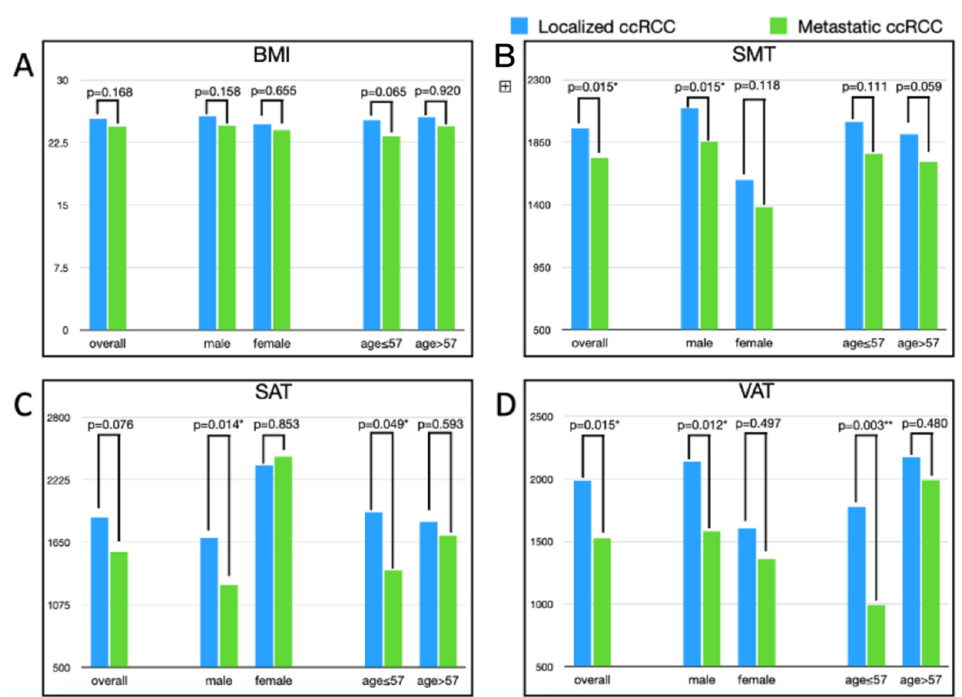
Figure 2. Comparison of body composition factors analysis between localized and metastatic RCC group in overall and subgroup (gender/age) analysis. ( A ) BMI; ( B ) SMT; ( C ) SAT; and ( D ) VAT. * p- value < 0.05; ** p- value < 0.01.